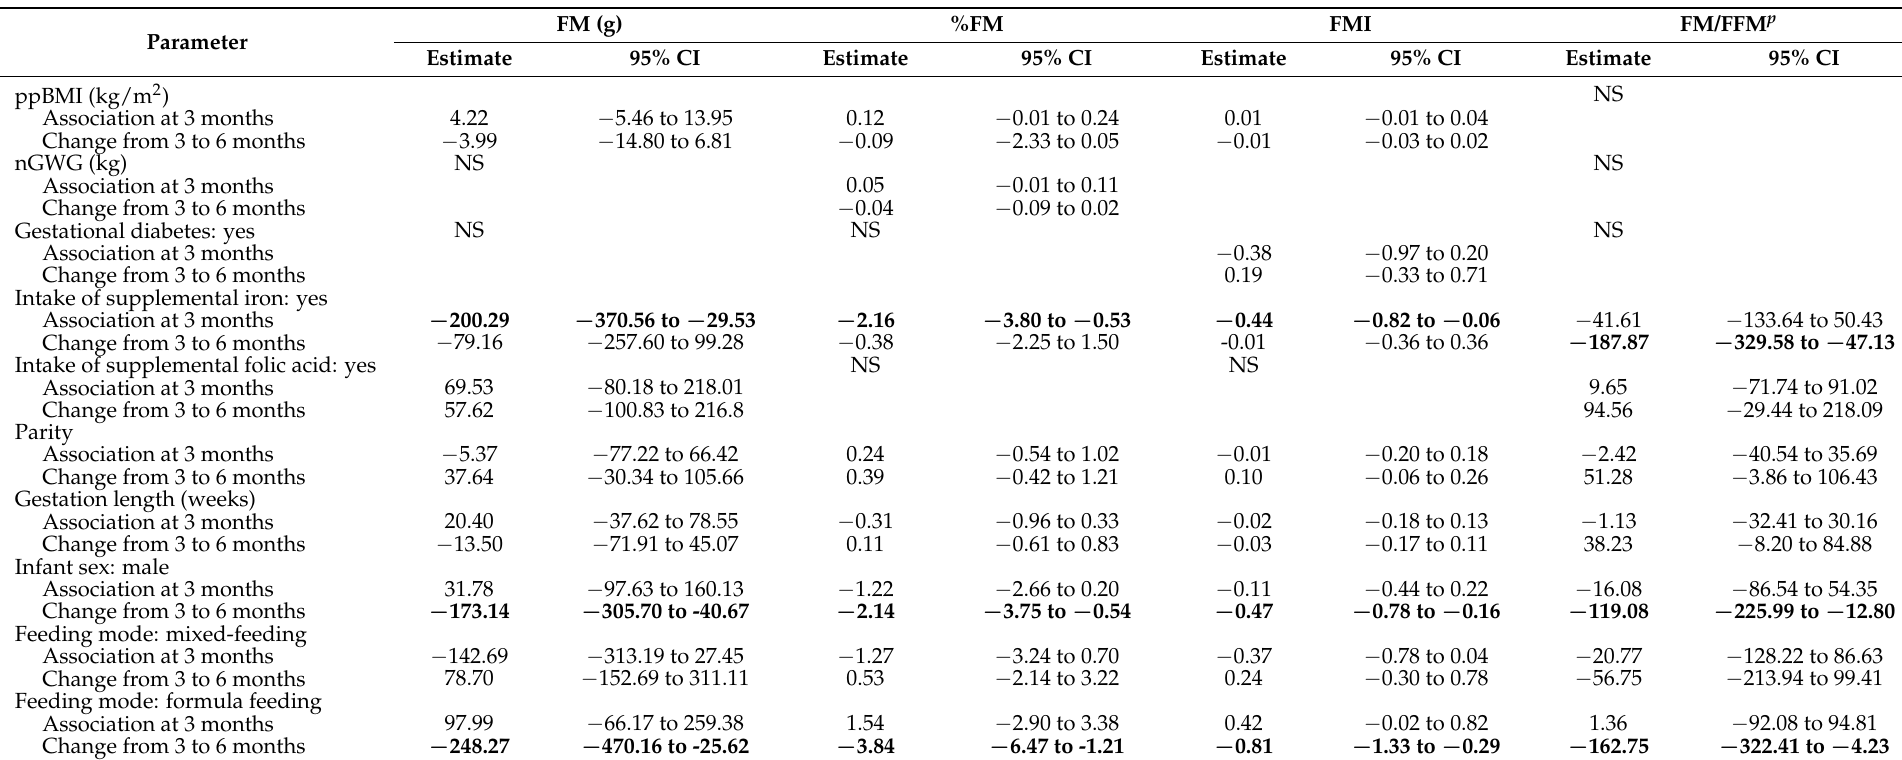
Table 4. Longitudinal associations between pre-pregnancy, prenatal and postnatal factors and indices of infant adiposity from 3 to 6 months. FM (g) %FM FMI FM/FFM p Parameter Estimate 95% CI Estimate 95% CI Estimate 95% CI Estimate 95% CI ppBMI (kg/m 2